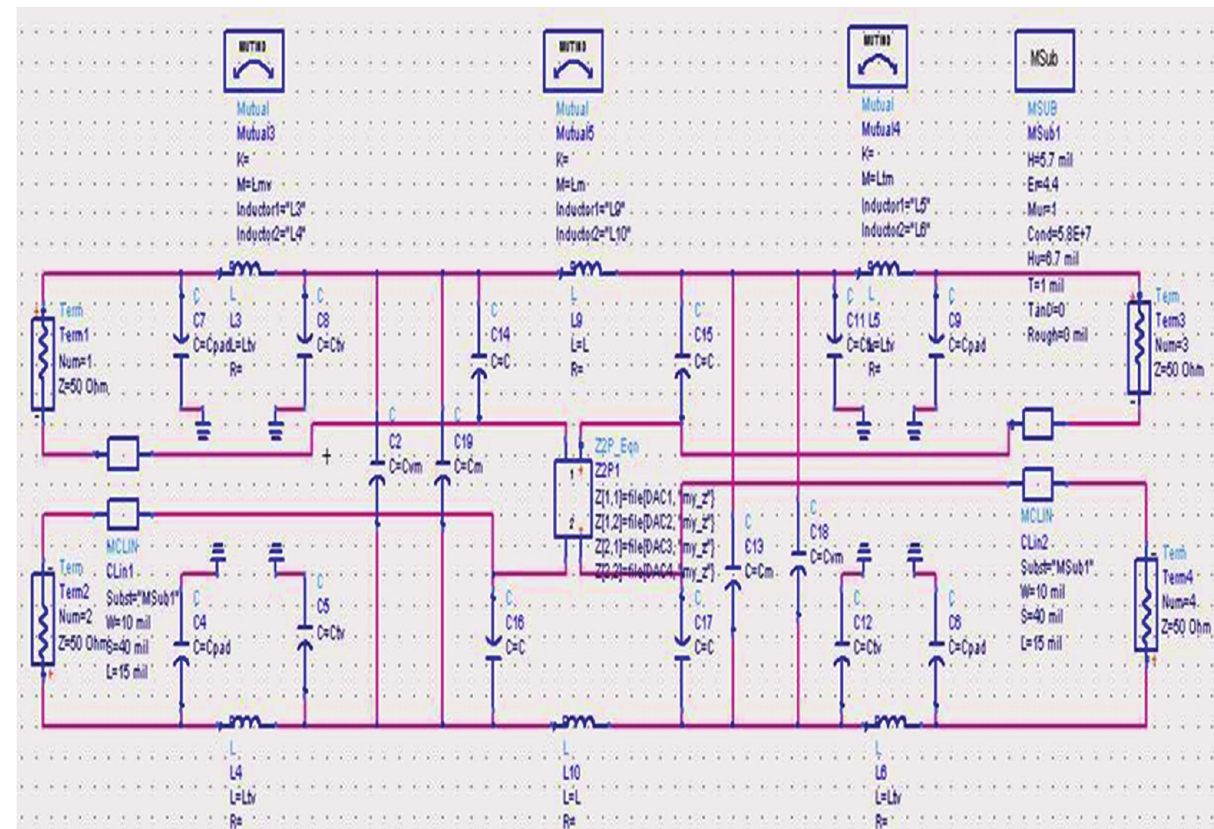
Figure 14: Equivalent circuit model of differential vias in single plane pair.